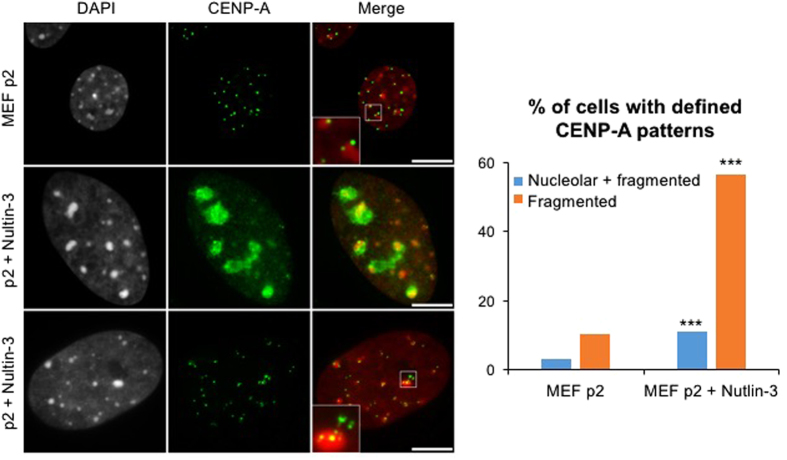
Perturbation of centromeres in senescent cells.CENP-A localization in Nutlin-3-induced senescent cells, analyzed as in Fig. 1A. Percentage of cells showing CENP-A nucleolar (as in middle panel) or fragmented (as in lower panel) patterns are represented on the histogram (n > 200 cells). Images represent one focal plan. Scale bar, 10 μm. ***p < 0.001 (chi-square test).